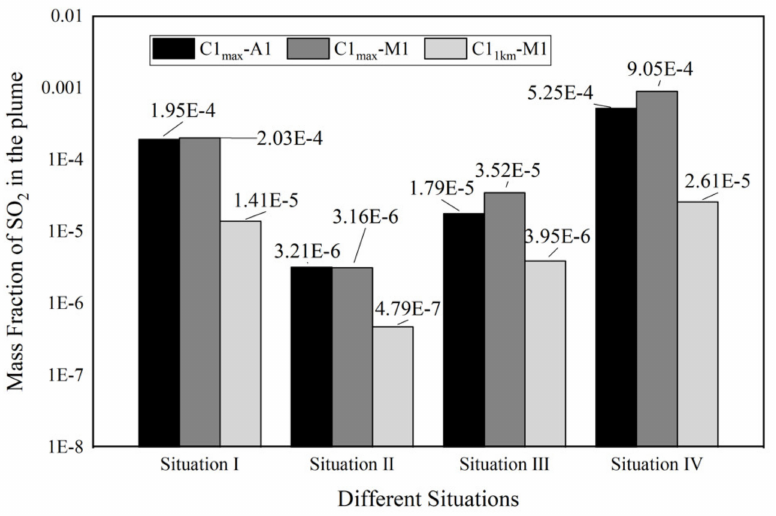
Figure 6. BL2 simulations: C1 on specified vertical planes in different situations (V wind = 5 m/s). The results in Figure 6 show a significant difference in C1 between different situations.